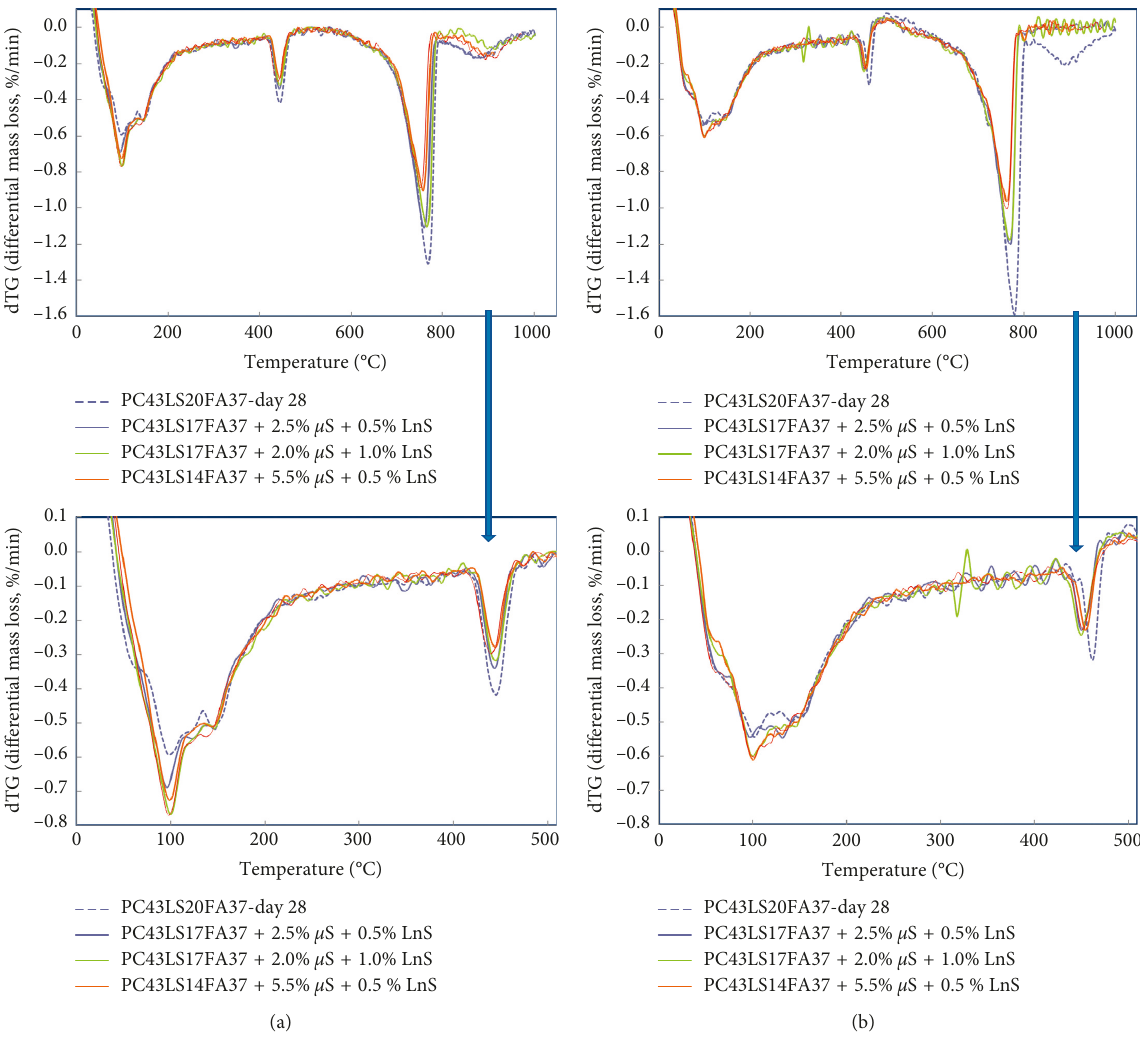
Figure 14: Differential mass loss of LnS and μ S nanocomposite binders based on PC43LS20FA37 between 0 and 1000 ° C at (a) day 28 and (b) day